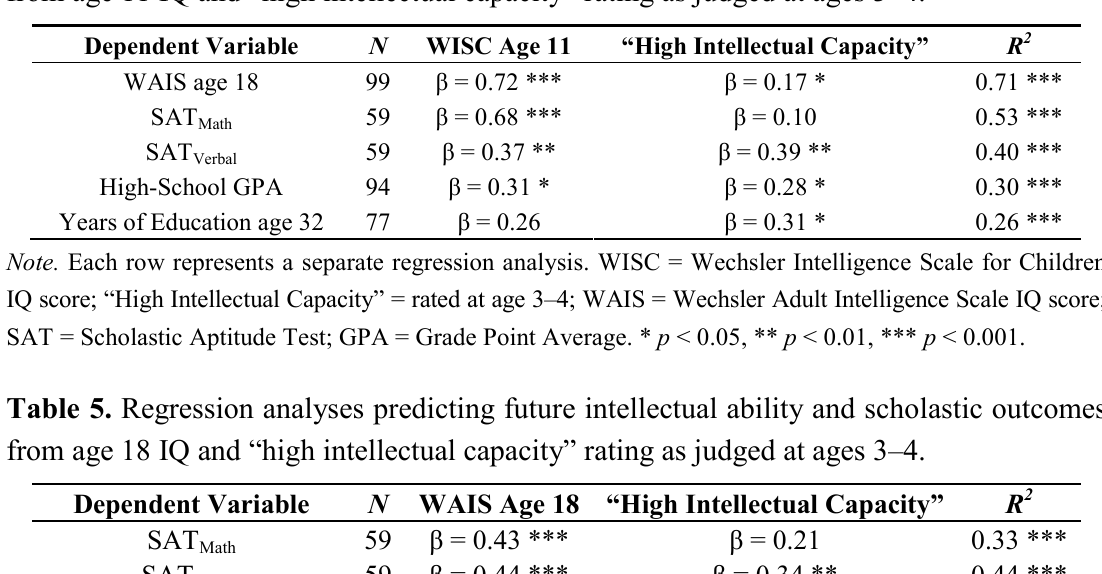
Table 4. Regression analyses predicting future intellectual ability and scholastic outcomes from age 11 IQ and “high intellectual capacity” rating as judged at ages 3–4.